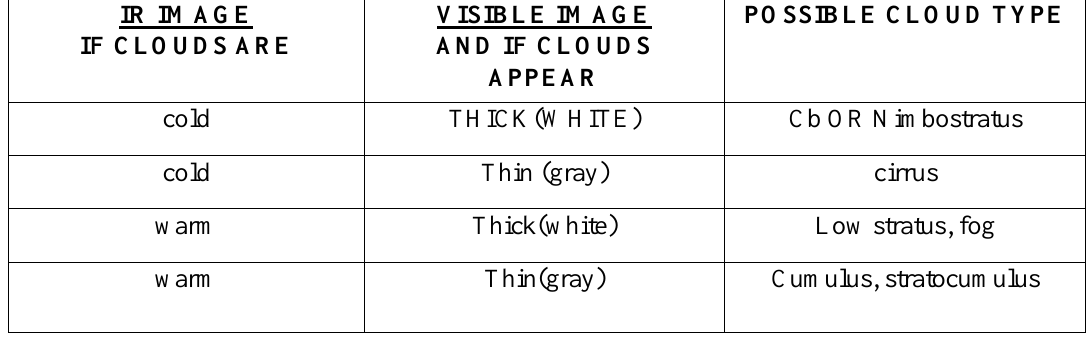
Table 4: Identify the cloud types from color both visible and infrared satellite images.